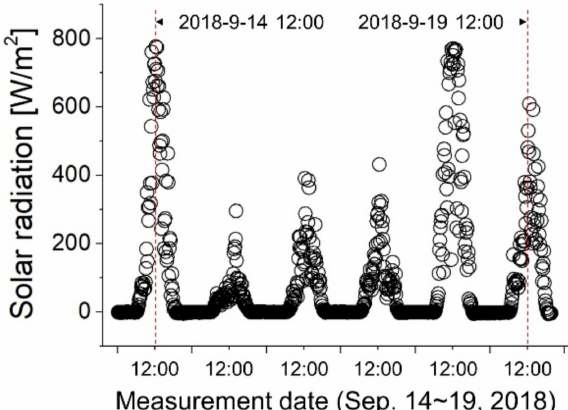
Figure 3. Measured solar radiation in Tongyeong City, South Korea.